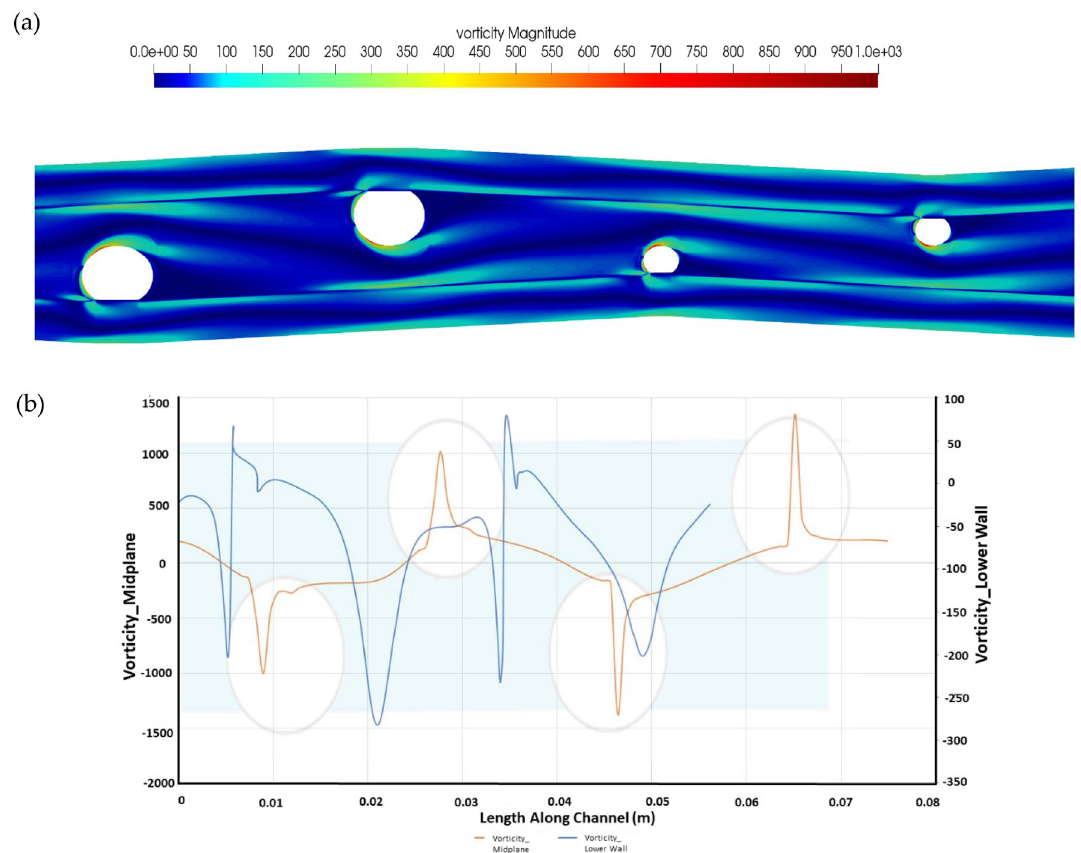
Figure 10. Vorticity plot for R2 ( a ) vorticity distribution along the channel and ( b ) center line vorticity vs. vorticity along the lower wall of the channel.